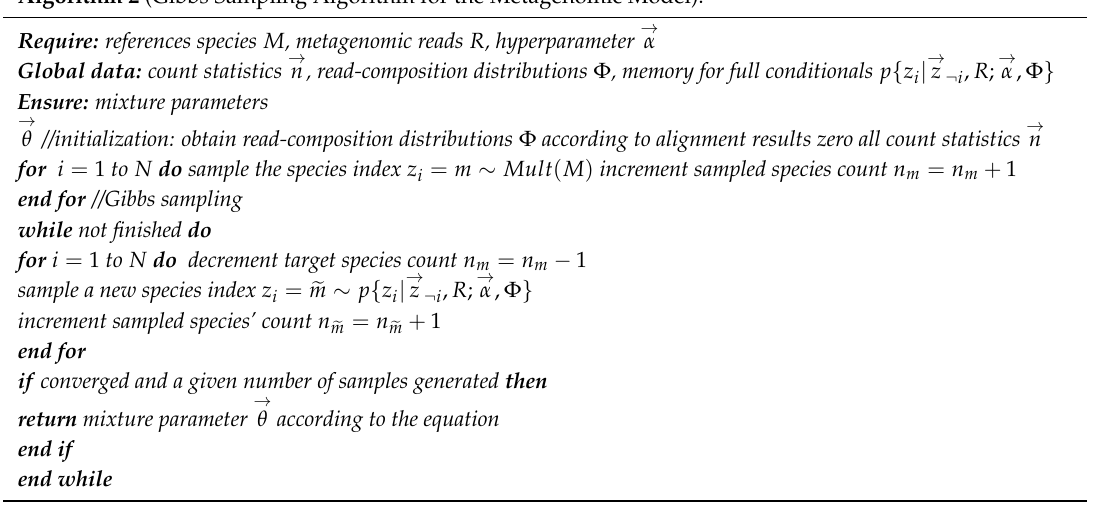
Algorithm 2 (Gibbs Sampling Algorithm for the Metagenomic